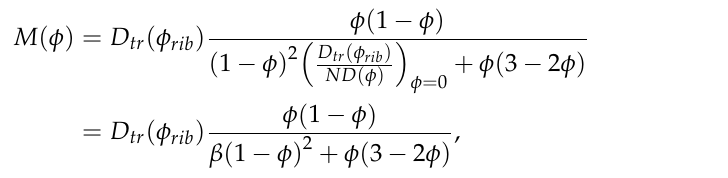
[ 0,1 ] ; ∈ 0.13 in human cells (HEK293) as experimentally ±